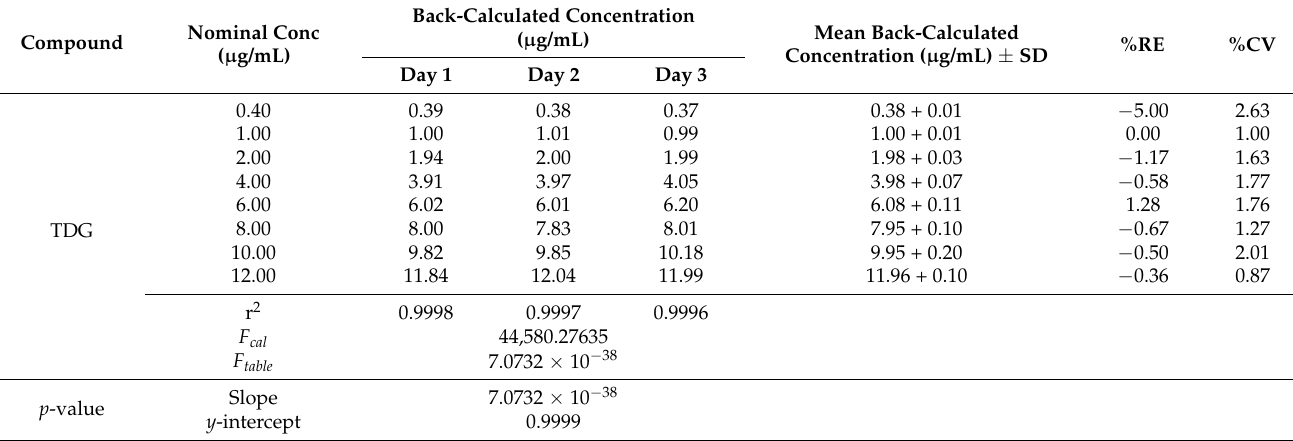
Table 3. Mean inter-day back-calculated standard and calibration curve results ( n = 3).